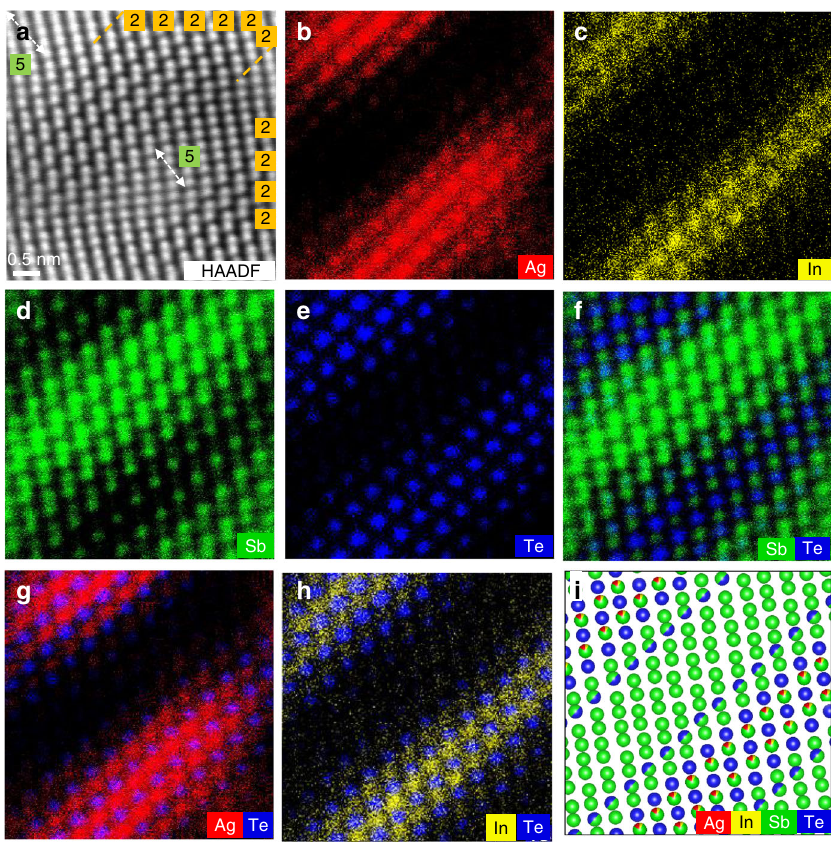
Fig. 2 Structural and chemical identi fi cations of an AIST crystallite, stacked by bilayers and quintuple layers. a HAADF-STEM image; the arrows mark the quintuple layers between two bilayers. b – h EDX mappings for Ag, In, Sb, Te, Sb + Te, Ag + Te, and In + Te elements, respectively. I: corresponding schematic atomic stacking model of crystalline AIST. The scale bar is 0.5